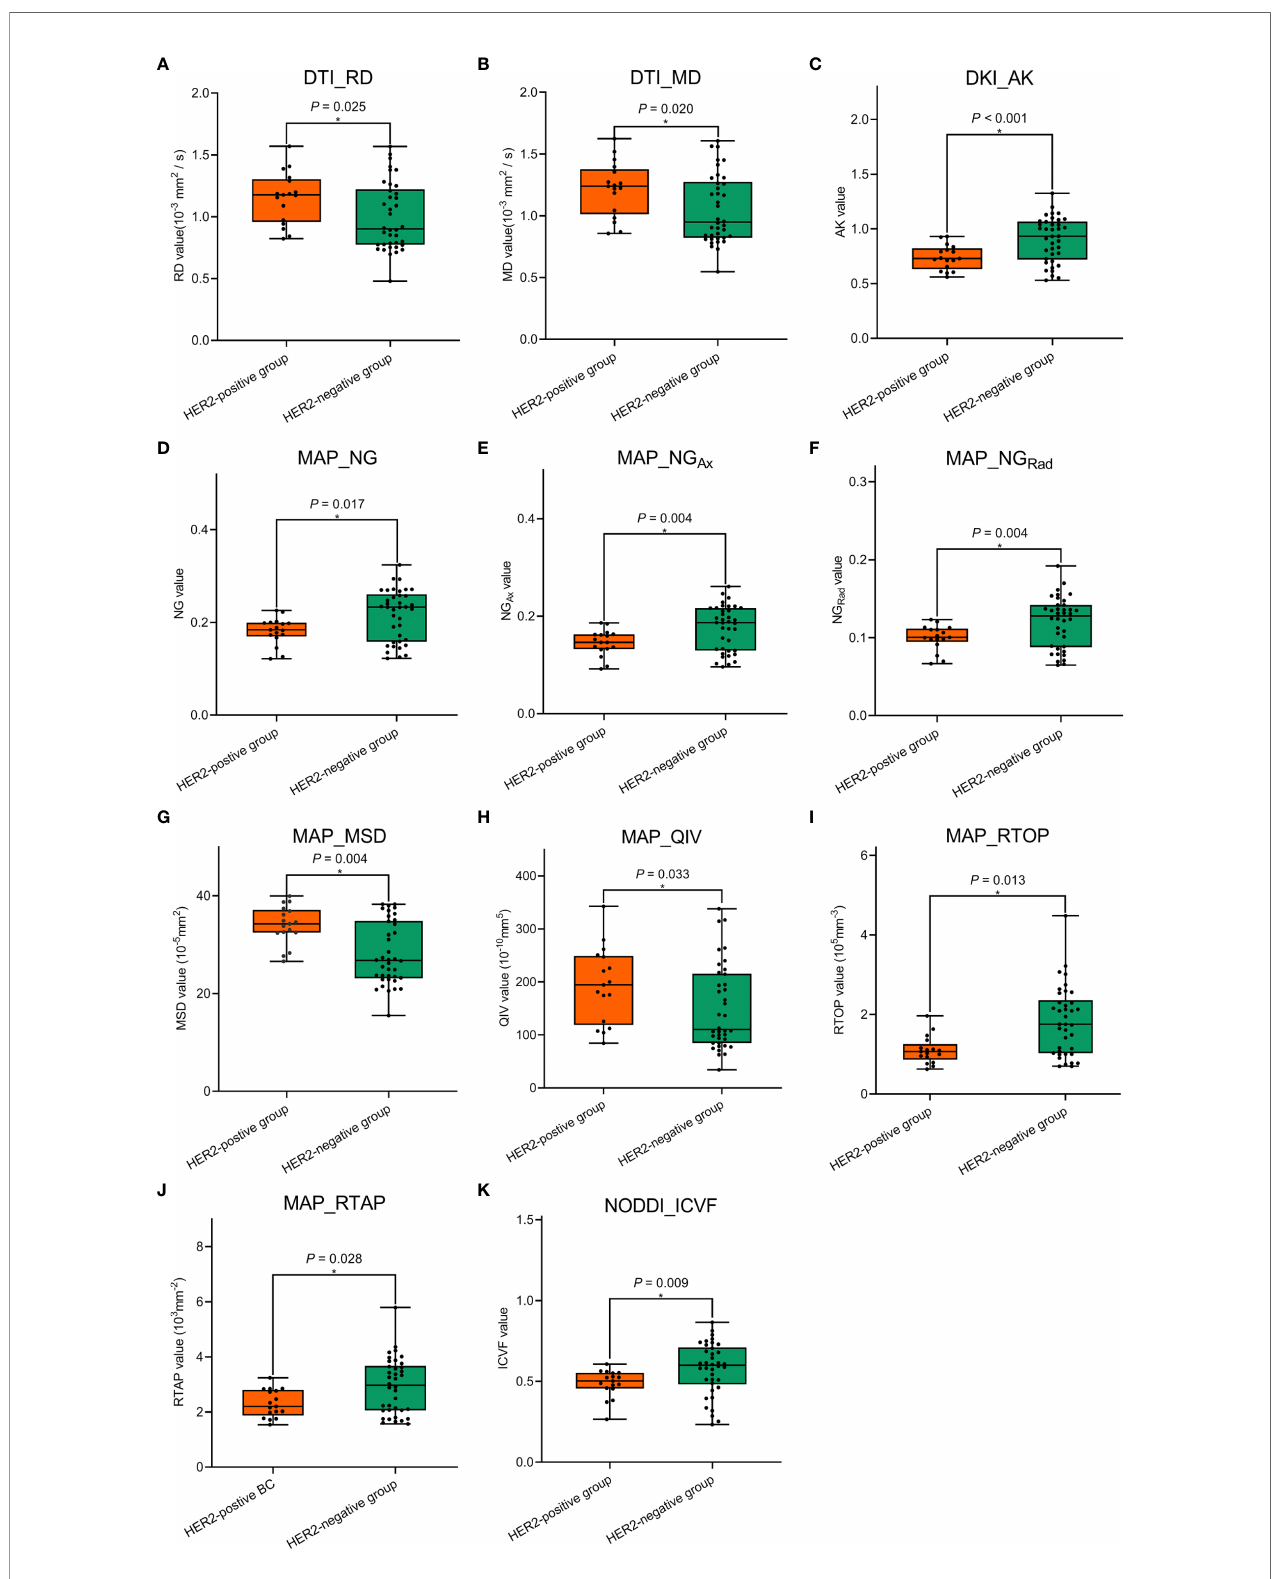
FIGURE 5 | Comparisons of the signi fi cant diffusion spectrum imaging (DSI) quantitative parameters (A – K) between the human epidermal growth factor receptor 2 (HER2)-positive group and the HER2-negative group in the validation cohort. * The statistically signi fi cant level, p <